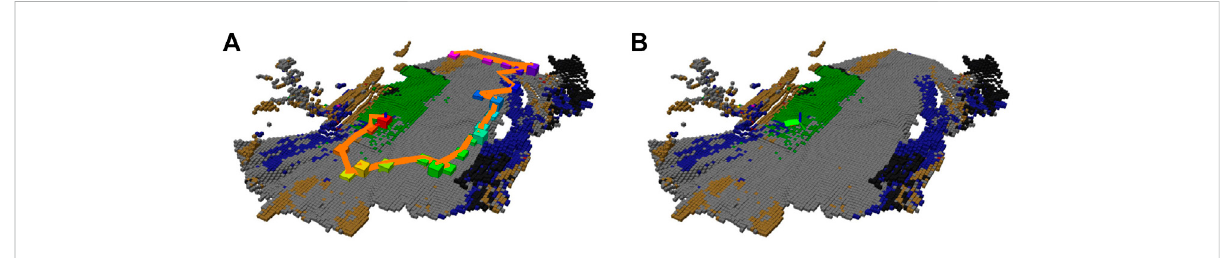
FIGURE 4 Anexampleofaplannedexplorationpath. (A) GlobalpathoverthesequenceofgoalsdeterminedbytheTSPsolver; (B) thelocalpathtothe fi rst